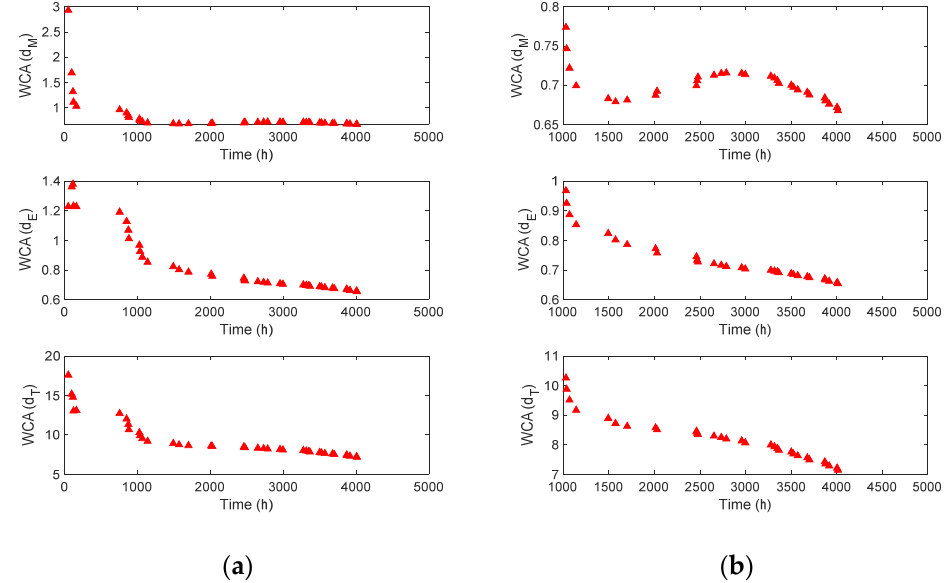
Figure 12. Degradation feature analysis based on proposed methods: ( a ) entire time scale; ( b ) after 1000 h.